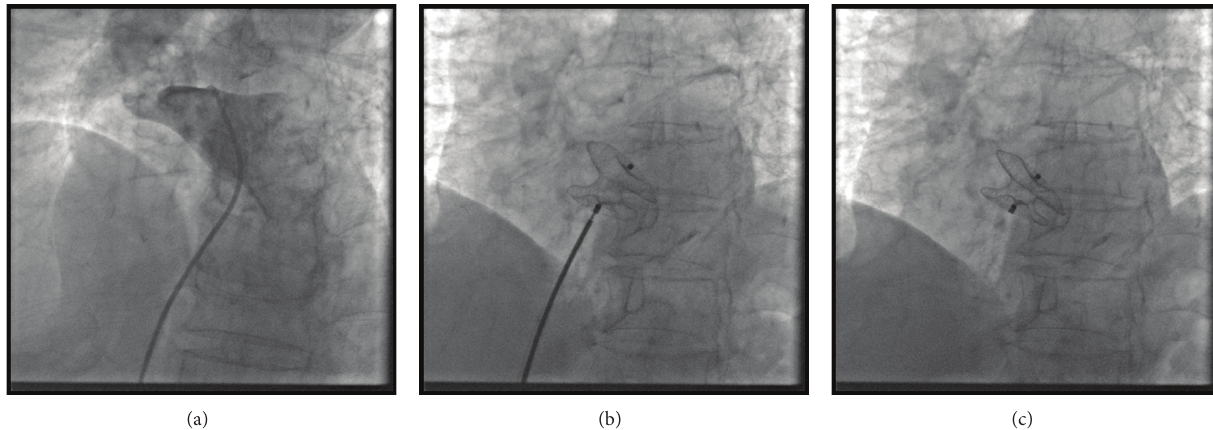
Figure1:(a)6-FrenchmultipurposecatheterpassedacrossthePFO.Arightupperlobepulmonaryvenousangiogramoutlinestheleftatrium. (b) An 18 mm Amplatzer device deployed but still attached to the release catheter. (c) Amplatzer device after release seen in stable